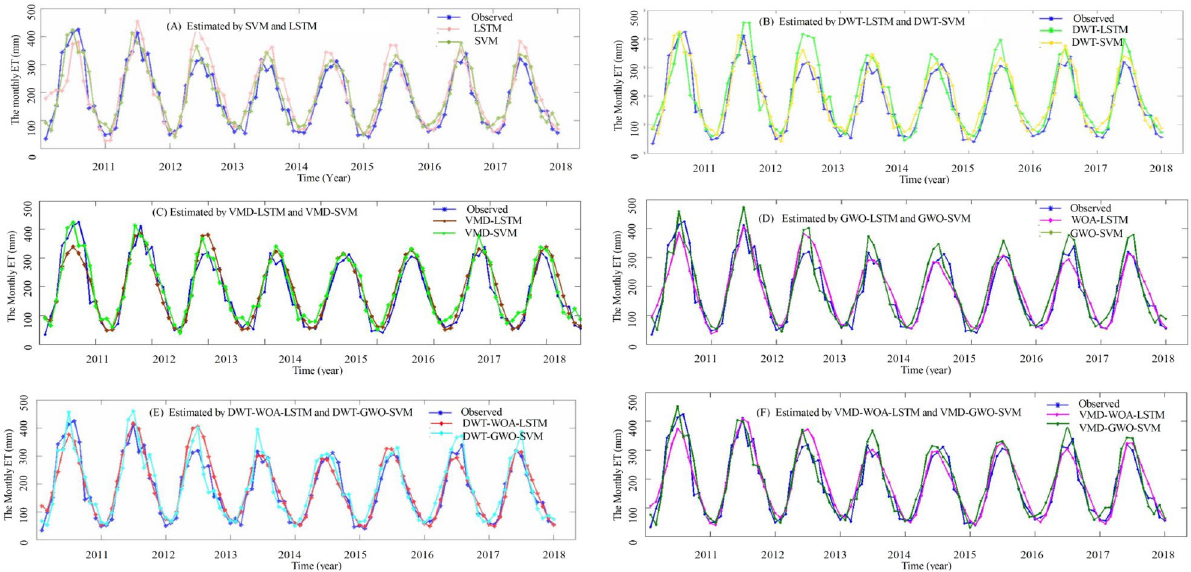
Figure 6. ET estimation using ( A ) LSTM and SVM, ( B ) DWT-LSTM and DWT-SVM, ( C ) VMD-LSTM and VMD-SVM, ( D ) WOA-LSTM and GWO-SVM, ( E ) DWT-WOA-LSTM and DWT-GWO-SVM, ( F ) VMD- WOA-LSTM and VMD-GWO-SVM.